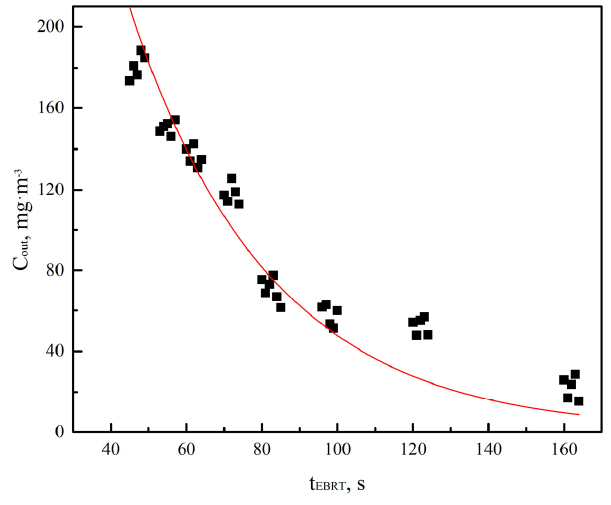
Figure 8. The relationship between outlet concentration of chlorobenzene and EBRT. (Liquid rate = 5.17 m 3 ·m − 2 ·h − 1 , pH = 6.5–7.0, oxygen concentration = 10%).